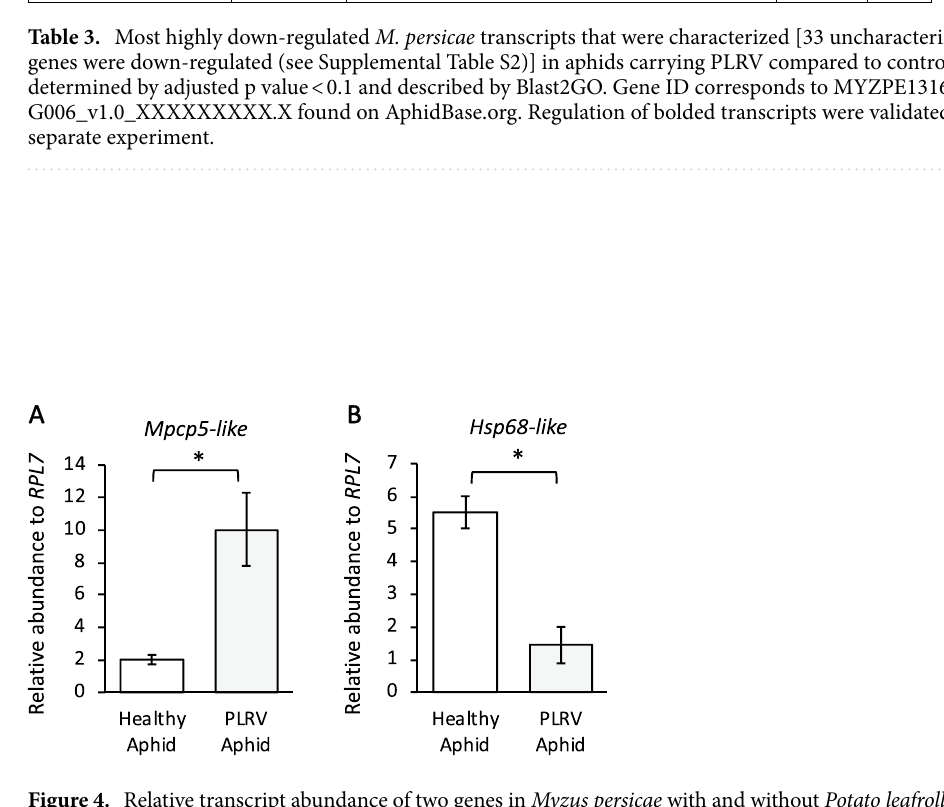
Figure 4. Relative transcript abundance of two genes in Myzus persicae with and without Potato leafroll virus (PLRV). (A) A cuticle related protein ( Mpcp5 -like) transcript was significantly up-regulated in expression in individuals with PLRV compared to virus free controls. (B) A predicted heat shock protein ( Hsp68 -like) was significantly down-regulated in expression in individuals with PLRV compared to controls. Transcripts were measured relative to a housekeeping gene RPL7 . Significant differences were calculated using an ANOVA (* P < 0.05; Error bars represent ±